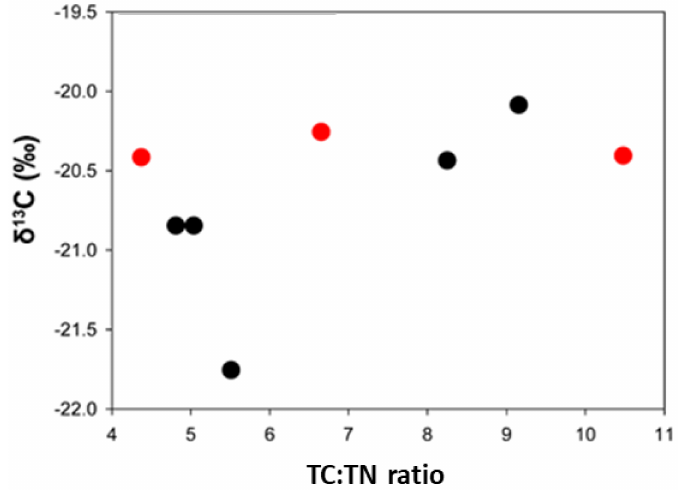
Figure 2. The correlation between the ratios of total carbon to total nitrogen and δ 13 C values in the sediments of the tidal flat of Yubu Island in the western coastal area of the Yellow Sea in South Korea. The red and black circles represent the unused saltern and southern tidal flats,